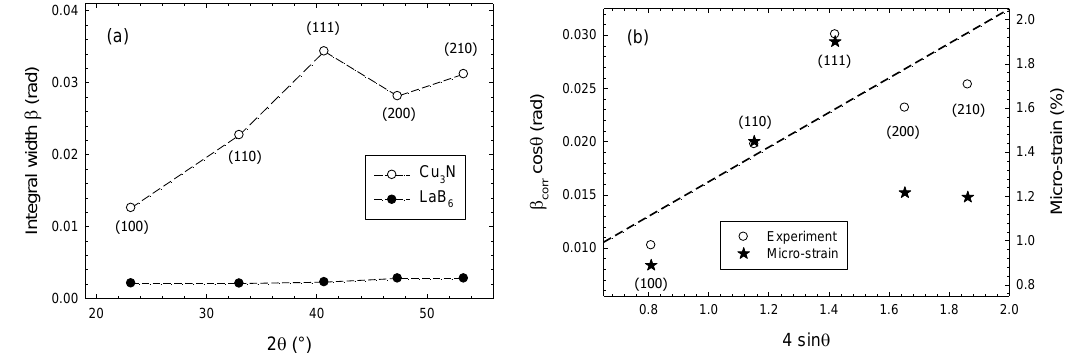
Figure 5. ( a ) Integral width β of Cu 3 N and reference material LaB 6 vs. diffraction angle. LaB 6 (SRM 660b) is used for the determination of the instrument profile function; ( b ) Williamson–Hall analysis and the extracted micro-strain of the Cu 3 N thin film. Dashed line is added to guide the eye only. Anisotropic line broadening of (100) and (200) line profiles may be caused by non-stoichiometry